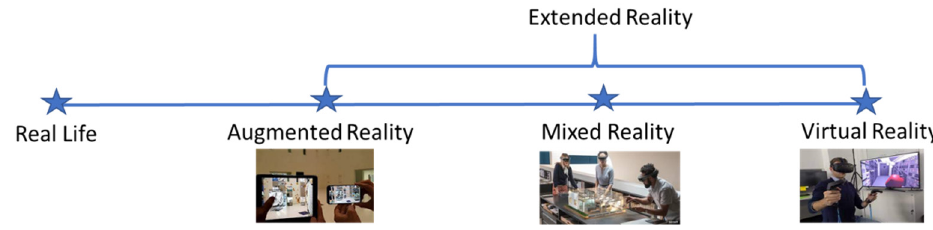
Figure 1. Extended Reality Spectrum.